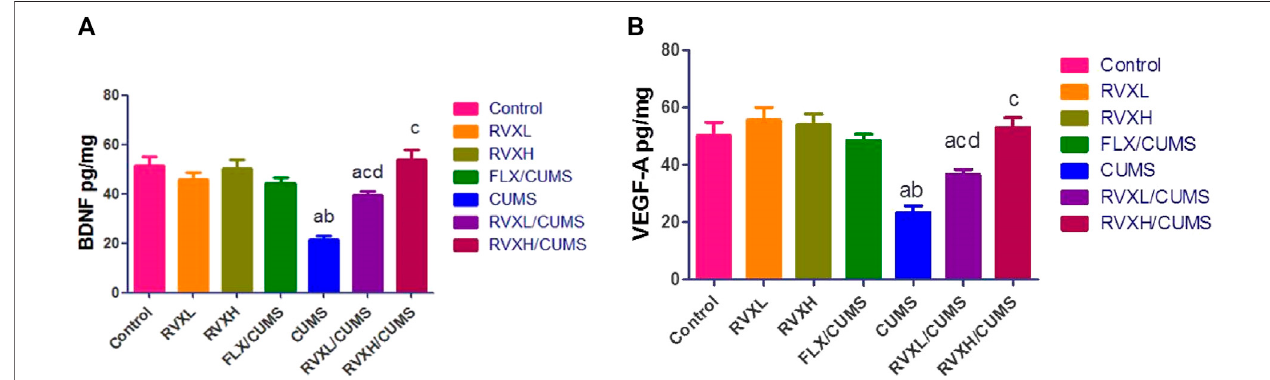
FIGURE2| EffectofRVXatdifferentdosesonBNDF( Figure1A )andVEGF-A( Figure1B )inthehippocampaltissue.The fi ndingsaredisplayed asmean ± S.E.M. Signi fi cant difference at p < 0.05. a signi fi cant difference compared to the control, b signi fi cant difference compared to the FLX group, c signi fi cant difference compared to theCUMSgroup,and d signi fi cantdifferencecomparedtoRVXH(BNDF: p < 0.0001,and p < VEGF-A:0.0004).BNDF,brain-derivedneurotrophicfactor;CUMS,chronic